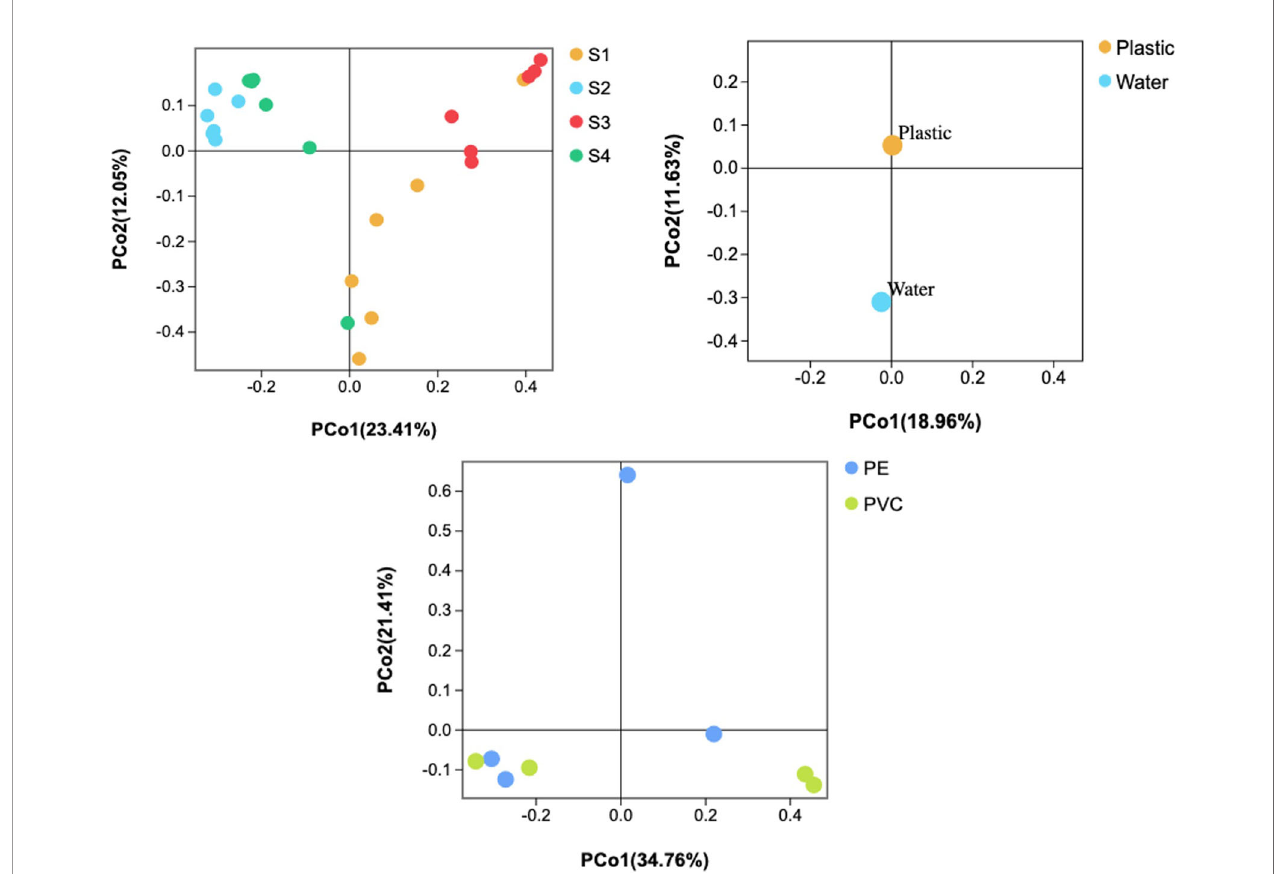
FIGURE 6 | Principal coordinate analysis (PCoA) of microbial communities based on the 16S rRNA sequencing pro fi